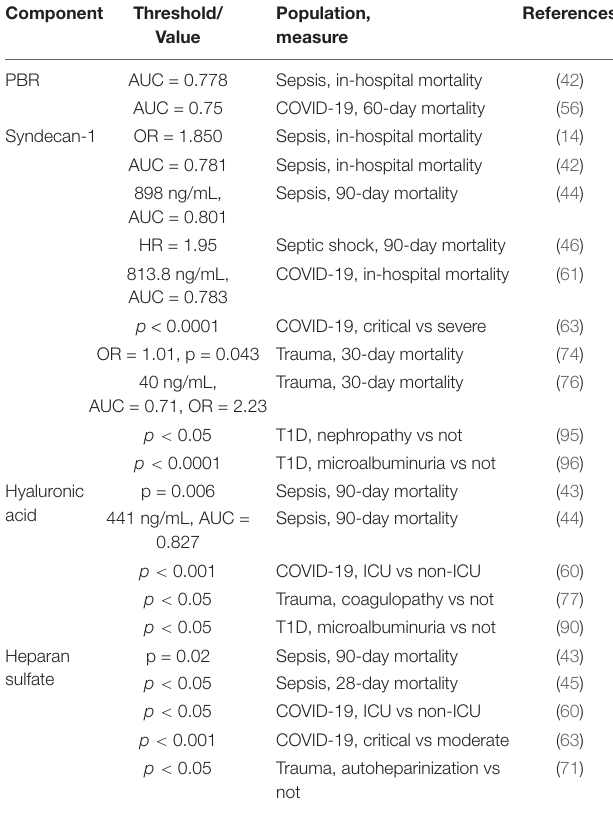
TABLE 2 | Glycocalyx components used as